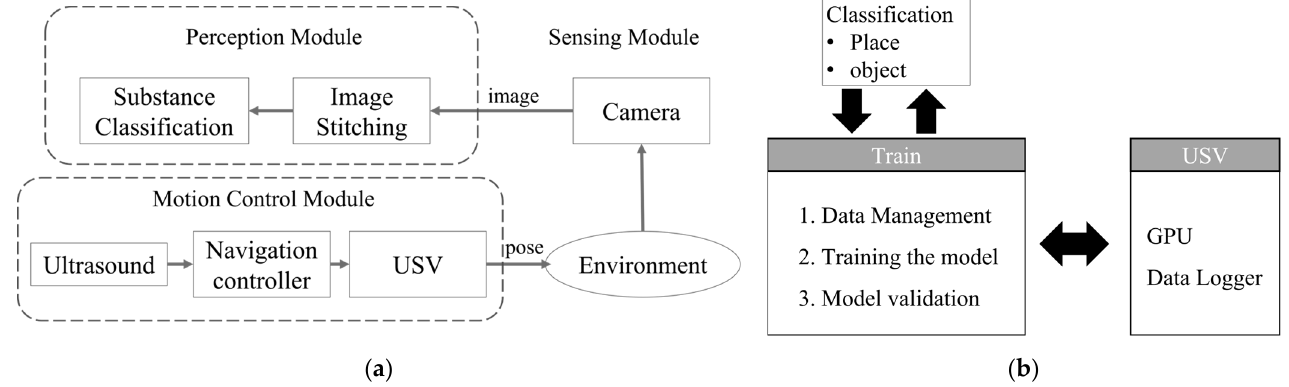
Figure 4. Overall system diagram as ( a ) system module; ( b ) system data training and classification.